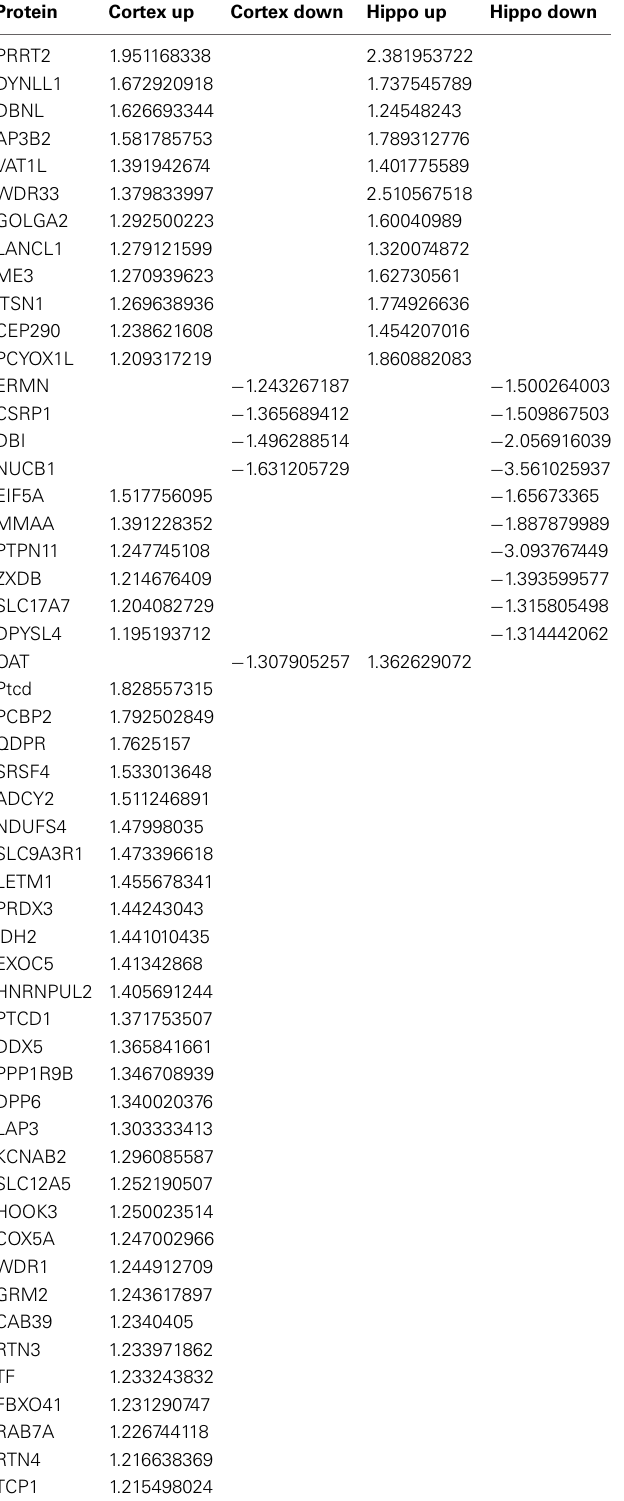
Table 7 | VennPlex Venn diagram analysis of up and downregulated proteins across the cortex and hippocampus of BTBR mice compared to WT